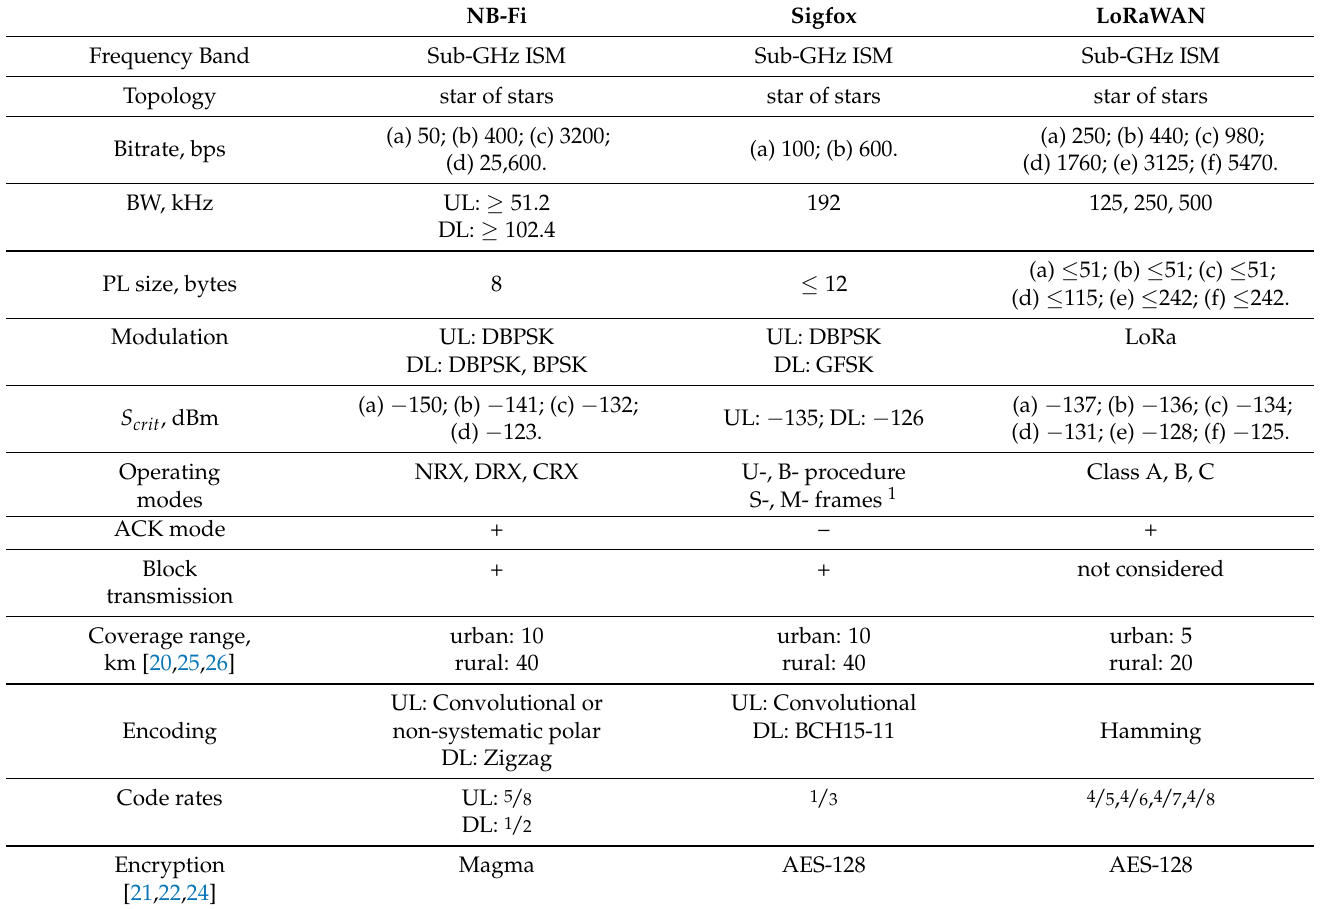
Table 1. Comparison of nominal properties of the considered technologies. NB-Fi Sigfox